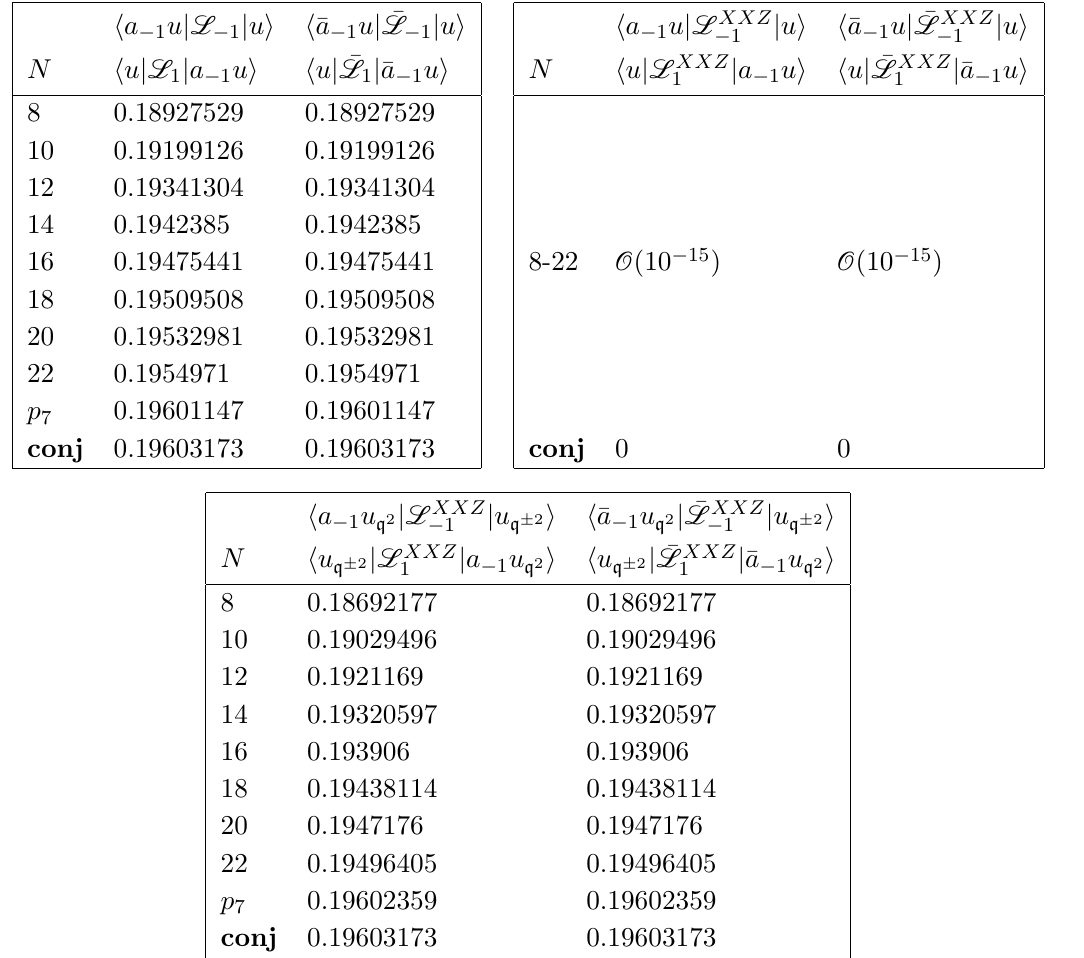
and (cid:22) L XXZ with the same conventions as in (cid:6) 1 (cid:6) 1 i the primary state q (cid:6) 2 0 ; q 2